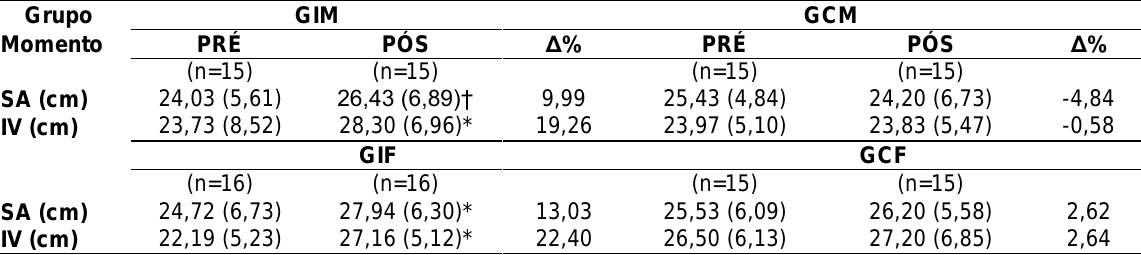
Tabela 3. Resultados das meninas (GIF e GCF) e dos meninos (GIM e GCM) nos Testes de “Sentar - e-Alcançar ” (SA) e Impulsão Vertical (IV) nos momentos antes (PRE) e após (PÓS) 12 semanas do programa de